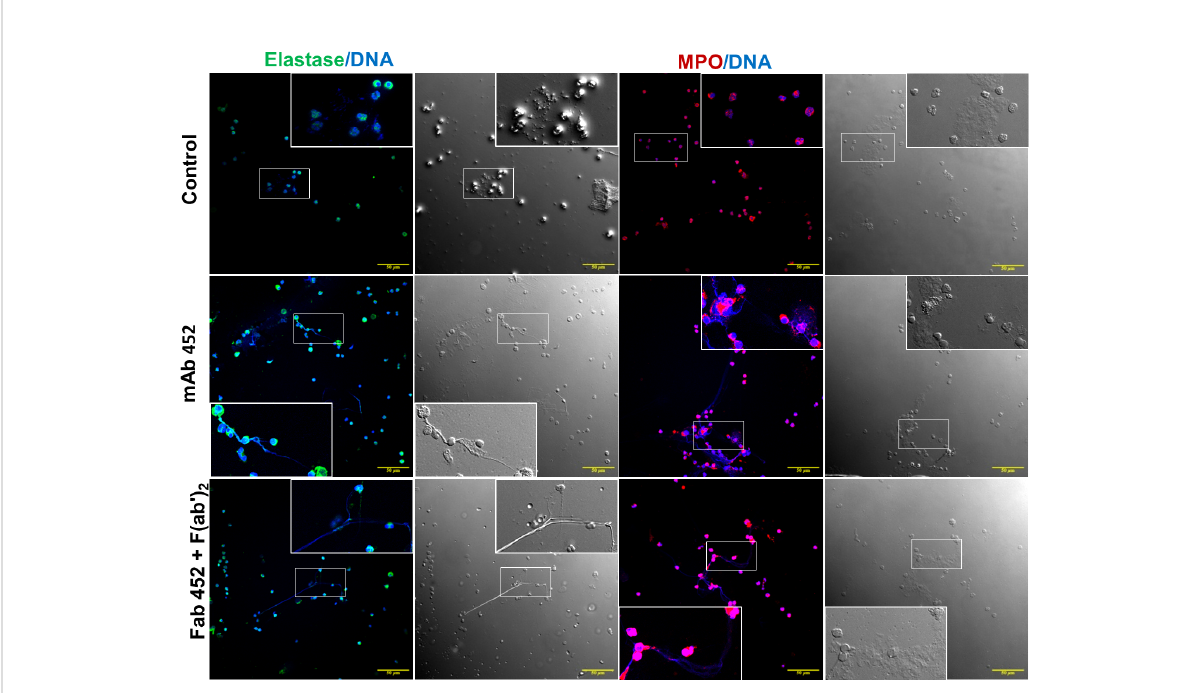
FIGURE 6 Myeloperoxidase and Neutrophil elastase are associated with extracellular DNA released after CD13 crosslinking. Confocal microscopy images of human neutrophils stimulated for 240 min with mAb 452, or Fab 452 plus F(ab ’ )2 fragments of anti-mouse Ig, or left unstimulated (control). Cells were fi xed and stained to visualize DNA (blue), myeloperoxidase (red) or neutrophil elastase (green). Each immuno fl uorescence image is shown together with its respective bright fi eld micrograph. Inserts show an enlargement of a selected area of each image. Bars: 50